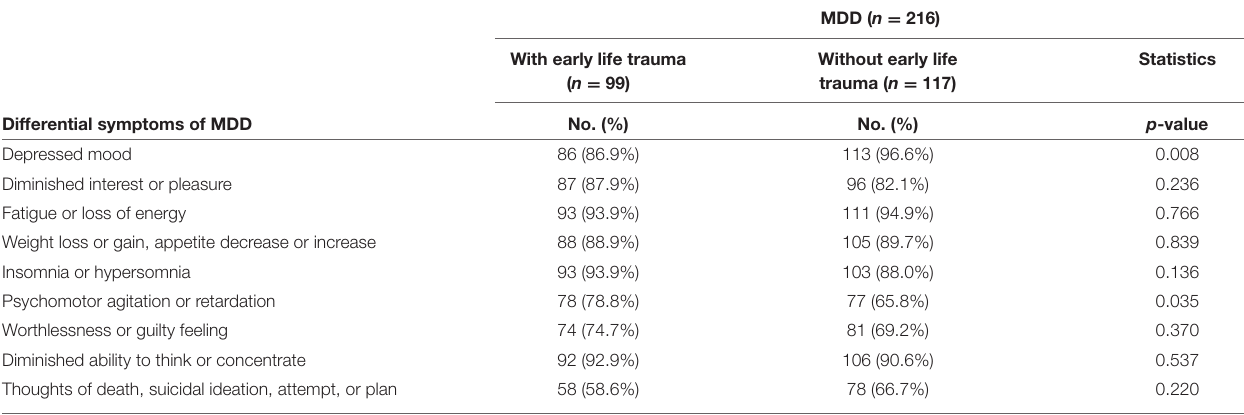
TABLE 4 | Comparison of the differential symptoms of major depressive disorder according to the presence or absence of early life trauma in participants reported as major depressive disorder in the Korean Epidemiological Catchment area study in 2016 (KECA-2016) ( n =